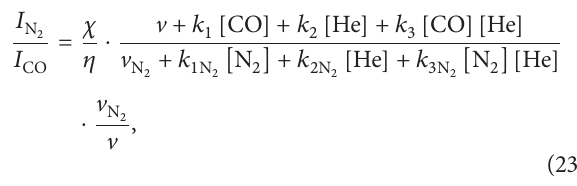
Figure 6: Intensity on 230 nm versus pressure of CO in He (400kPa) + CO and Ne (122kPa) +